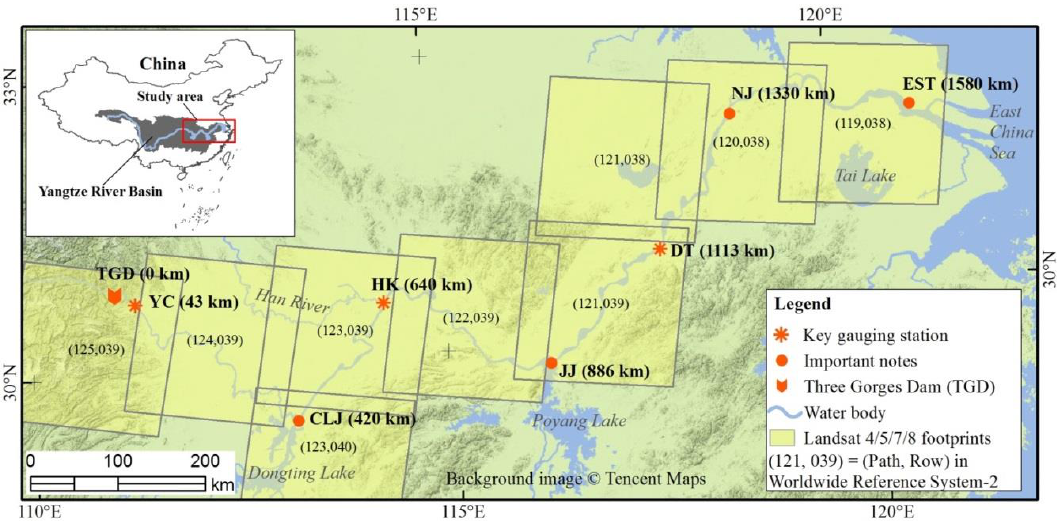
Figure 1. Geographic location of the study area (downstream of the Three Gorges Dam or TGD) and corresponding footprints of Landsat 4/5/7/8 images. Location names, TGD, YC, CLJ, HK, JJ, DT, NJ, and EST, are the acronym of Three Gorges Dam, Yichang, Chenglinji, Hankou, Jiujiang, Datong, Nanjing and estuary of the Yangtze River, respectively. The closed number following location name indicates the downward distance of that location from TGD. For example, “YC (43km)” means Yichang gauging station is located at 43 km downstream of TGD.